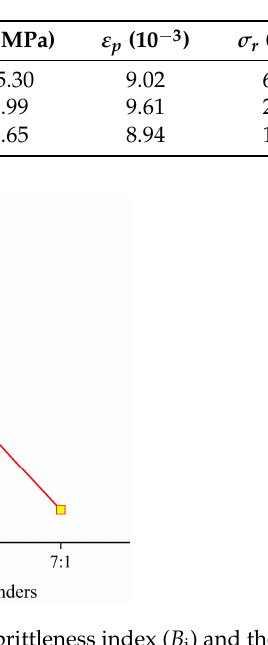
Table 6. Calculation of the brittleness index.